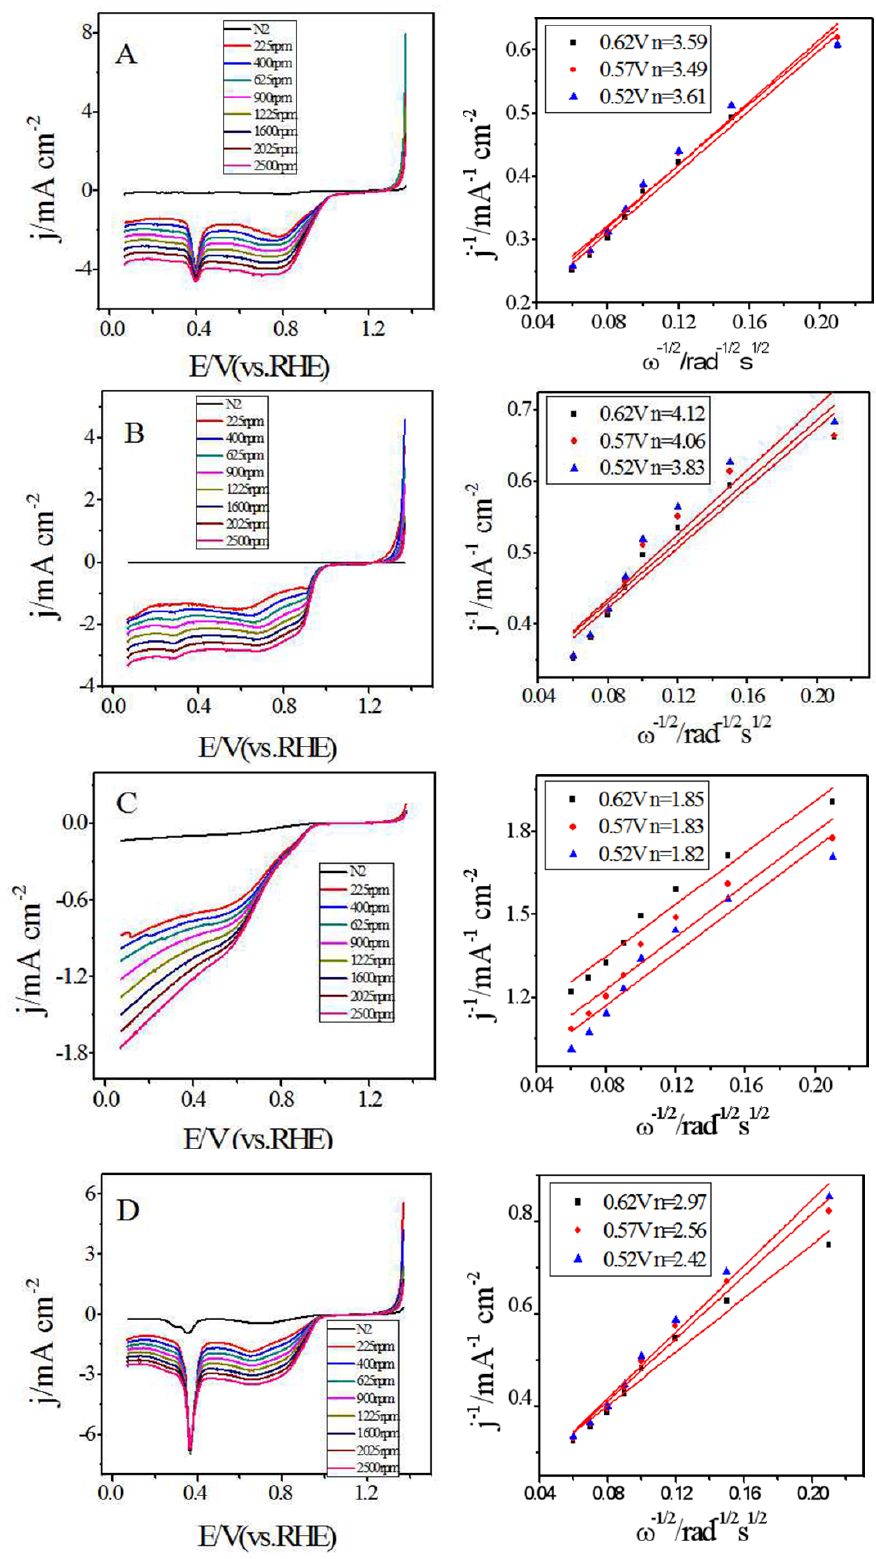
Figure 8. Linear scanning voltammetry (LSV) curves for the Pt-Bi (Bi 2 O 3 )/GNs (PVP) ( A ), 30% PtRu/C-JM ( B ), Pt/GNs (PVP) ( C ), Pt-Bi (Bi 2 O 3 )/GNs ( D ) in an O 2 saturated 1.0 M NaOH solution at different rotation rates.